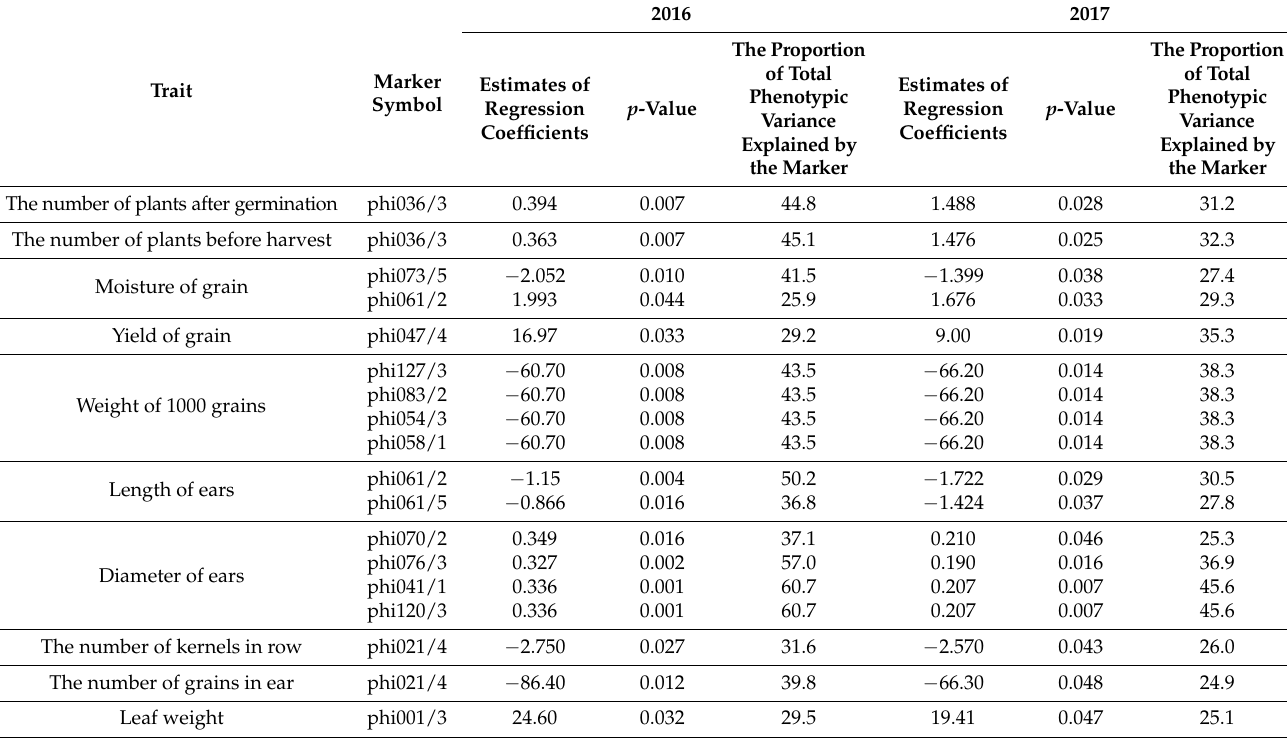
Table 3. Molecular markers associated with observed traits in both years of